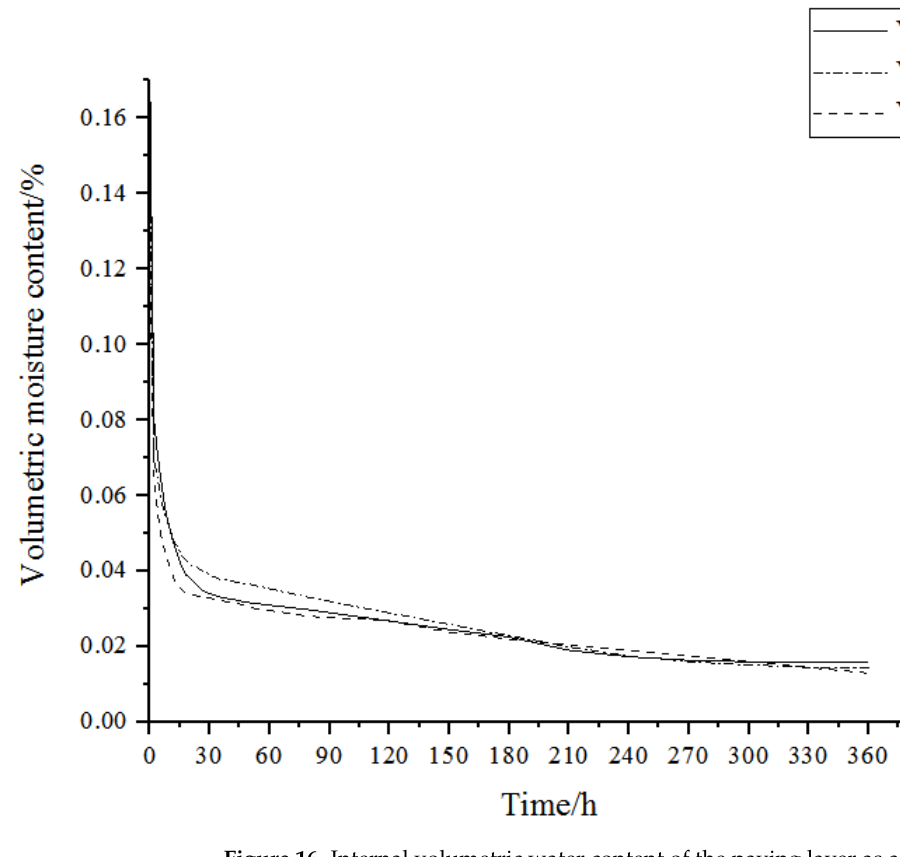
Figure 16. Internal volumetric water content of the paving layer as a function of time.